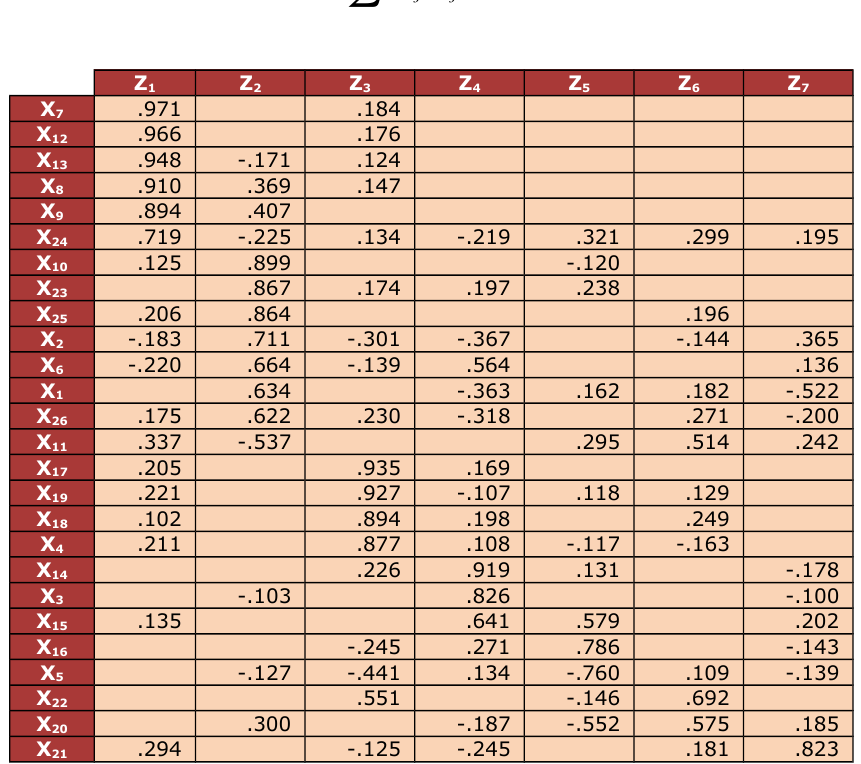
Table 3. Rotated Component